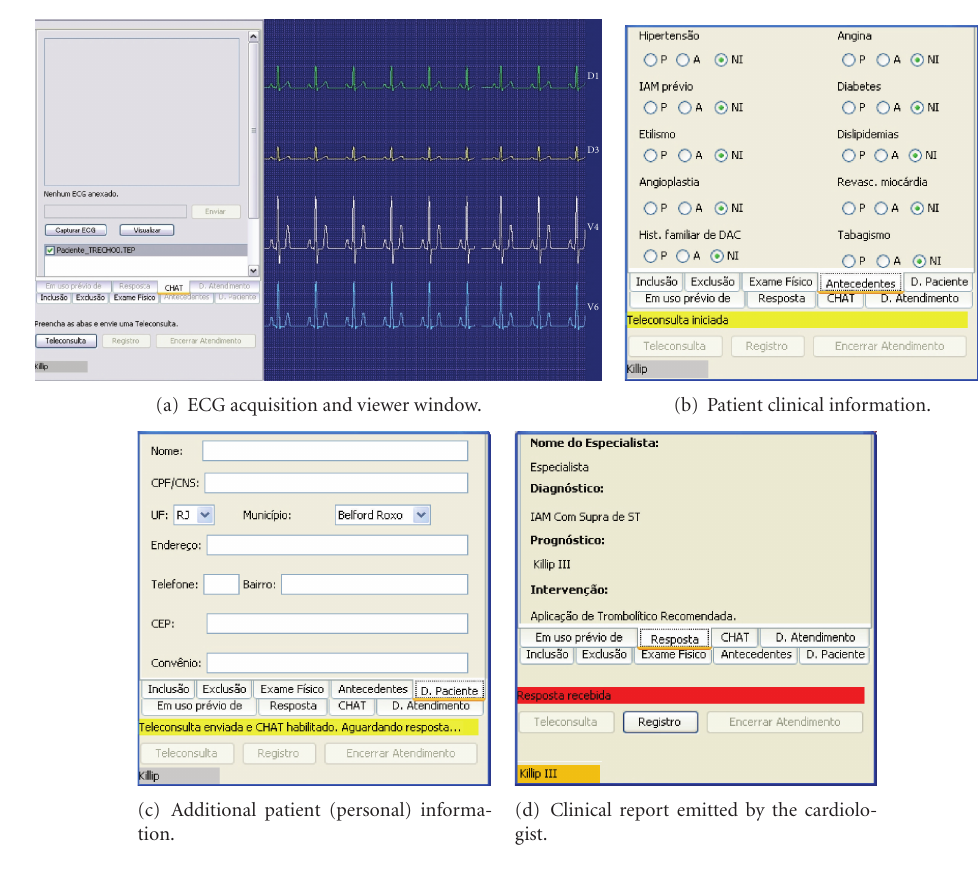
Figure 4: Graphical user interfaces of the paramedics’ endpoint.